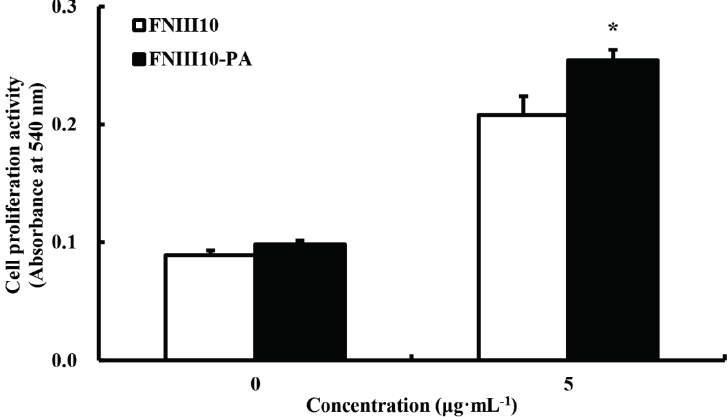
Figure 4. Cell proliferation activities of FNIII10-PA on rMSCs at 5 days. Twenty-four well plates were coated with 5 μ g·mL − 1 of FNIII10 or FNIII10-PA overnight at 4 ° C. Cells were seeded at a density of 1 × 10 5 cells/well on the plates and incubated for 5 days at 37 °C. Formazan absorbance was used as a measure of cell proliferation. Cell proliferation activities are presented as means ± SD ( n = 3). * p <